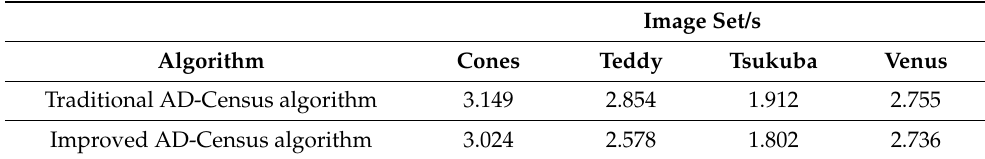
Table 1. Comparison of algorithms’ running times.